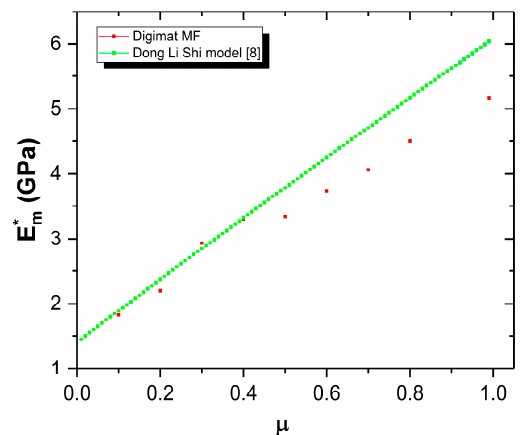
Figure 12. Effective elastic moduli E ∗ m of a matrix reinforced by agglomerated randomly oriented nanofillers, a comparison between Digimat MF and Mori–Tanaka scheme.